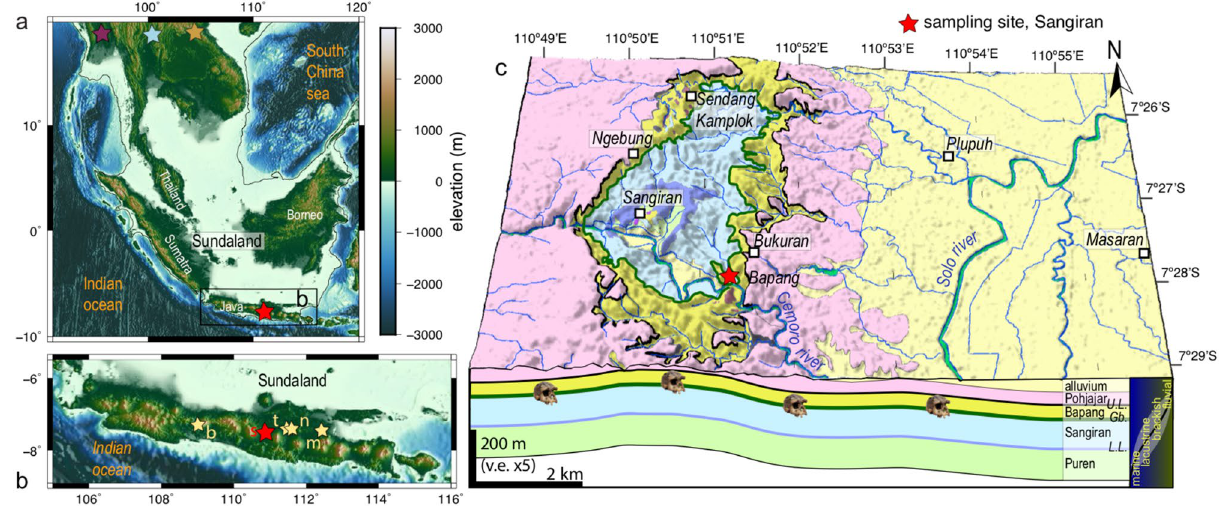
Figure 1. Geology of Sangiran. ( a ) Regional view. Black line delinates continental Sundaland (120 m isodepth). Stars indicate possible northern entry points (thereafter set to Myanmar, Thailand and Vietnam) for H. erectus . ( b ) Java island and main biostratigraphic sites (hominin-bearing sites: Sangiran (s), Mojokerto (m), Trinil (t), Ngandong (n); and faunal site Bumiayu ( b ). ( c ) 3D view of the Sangiran dome. Geological map redrawn from 15,22 . Red star locates Bukuran creek outcrop; skull is Sangiran-17 23 . Maps on panels ( a , b ) were created using GMT 5 (www. gener ic- mappi ng- tools. org) 24 ; on panel ( c ). using ArcGIS (www. arcgis.